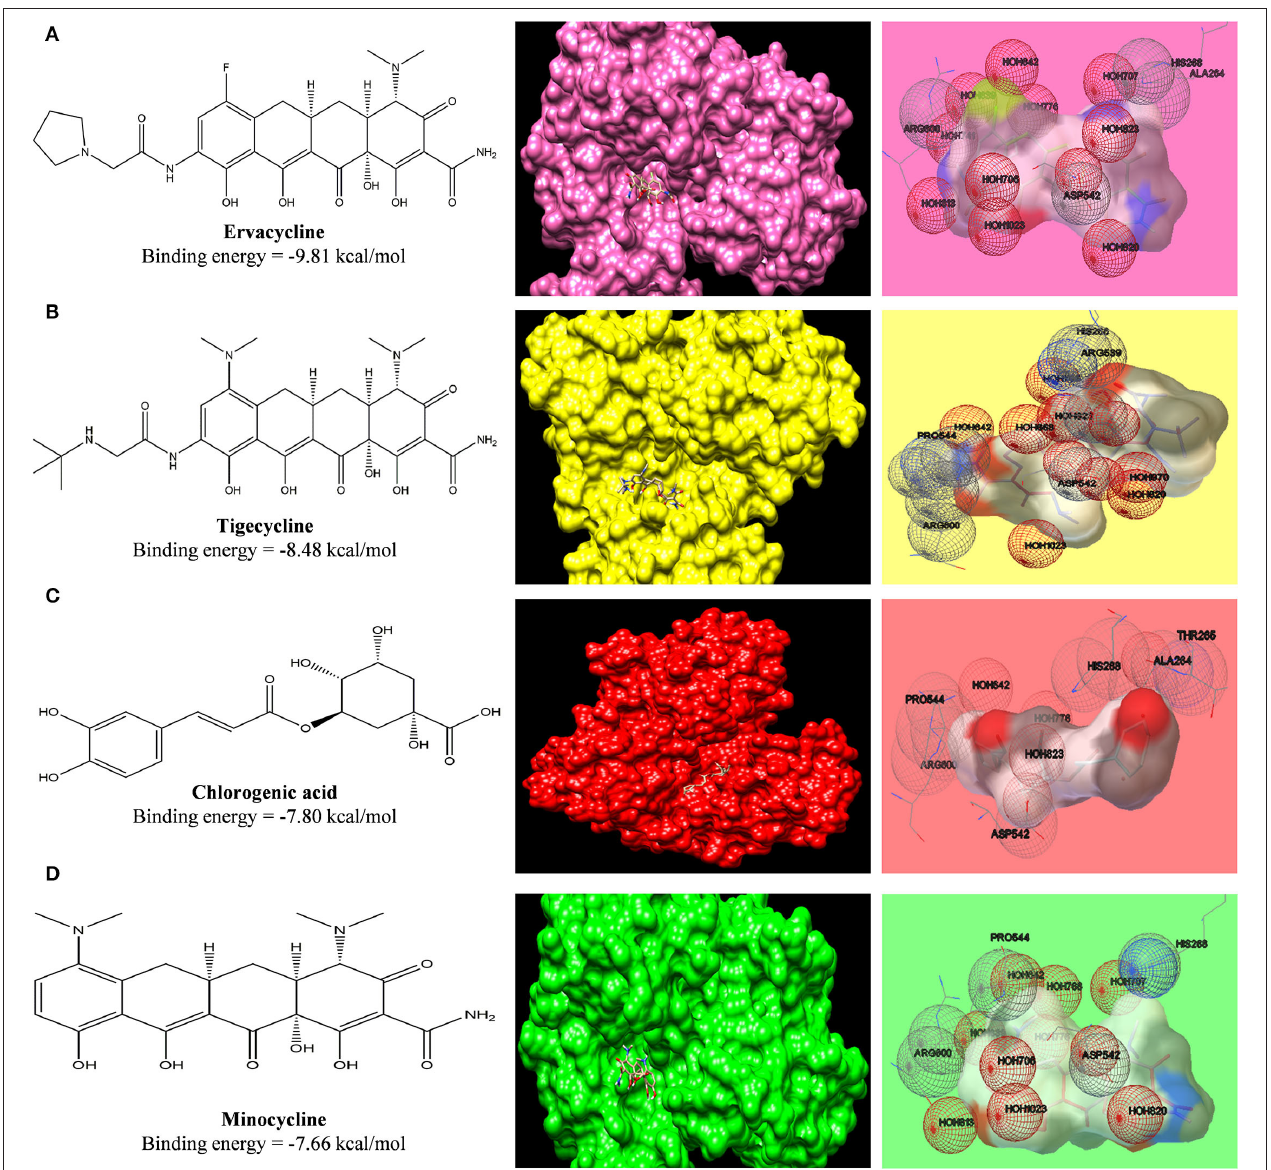
FIGURE 11 | Computed structural comparison and binding features (visualization using UCSF Chimera and AutoDock) of Ervacycline (A) , Tigecycline (B) , Chlorogenic acid (C) , and Minocycline (D) , with NS3 helicase/nucleoside triphosphatase of Japanese encephalitis. The lower the binding energy, the greater will be the binding affinity.